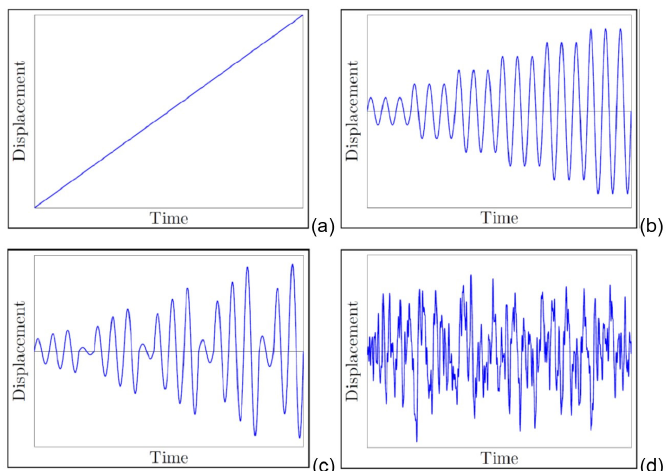
Figure 6. Loading patterns: (a) monotonic; (b) amplified cyclic; (c) sequential-phase cyclic; (d) simulated seismic [10].